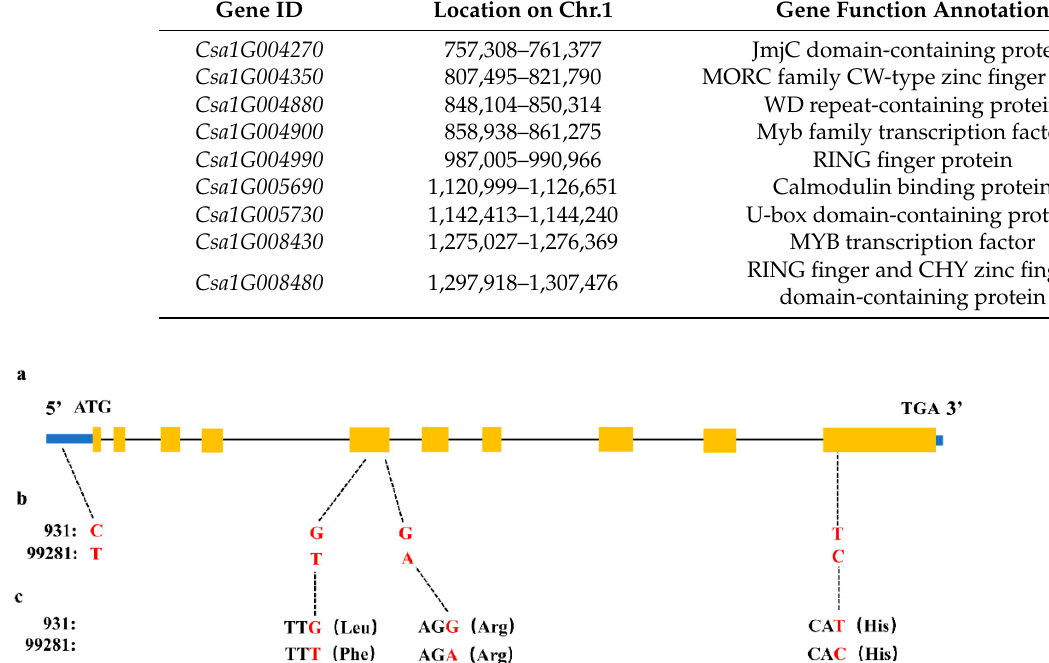
Table 3. Analysis of candidate genes related to cucumber heat tolerance.